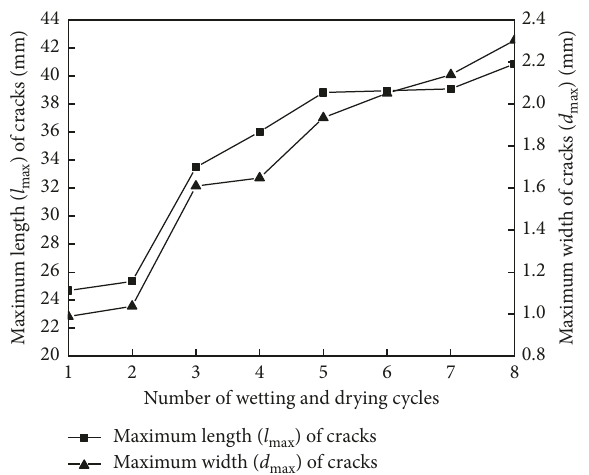
Figure 8: Curves of maximum length and maximum width of